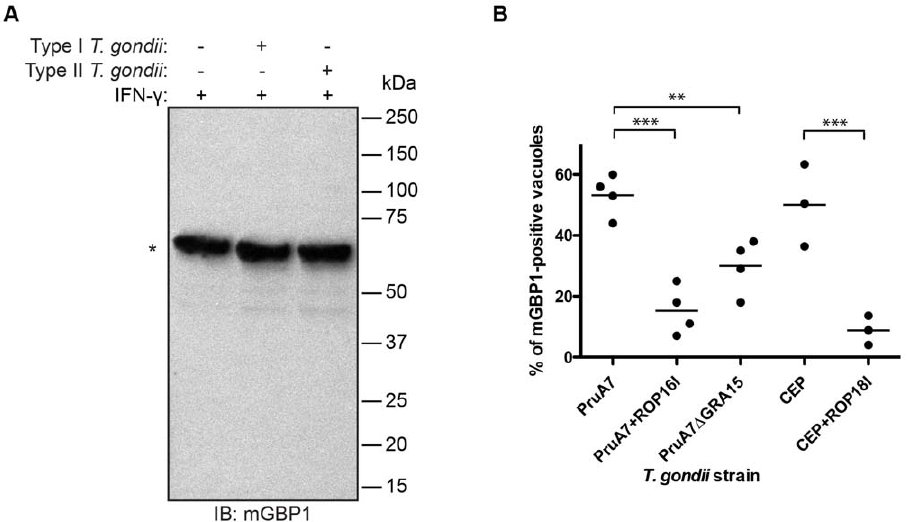
Figure 2. T.gondii cannot degrade mGBP1 but parasitic virulence factors interfere with recruitment of mGBP1. (A) Degradation of mGBP1 after invasion of T. gondii is not detectable by IB. RAW264.7 cells were induced with 200 U/ml IFN- c overnight and infected with mCherry- expressing T. gondii (Pru or RH). Infected cells were separated from uninfected cells by FACS 2 h post-infection. For each lysate, 50 m g of protein, which was equivalent to 300,000 cells, were loaded per lane. The mGBP1 protein was detected by rabbit polyclonal anti-mGBP1 antiserum (*). (B) Type II strains with deleted GRA15, type II strains transgenic for the type I version of ROP16, and type III strains transgenic for the type I version of ROP18 show less mGBP1-positive vacuoles compared to the parental strain. MEFs that overexpress eGFP-mGBP1 were induced with 200 U/ml IFN- c and infected with PruA7, a Pru type II T. gondii strain, PruA7 either lacking GRA15 or transgenic for the type I version of ROP16, CEP, a type II strain, or CEP transgenic for the type I version of ROP18. For each strain, at least 100 vacuoles of invaded T. gondii were checked for recruitment of mGBP1. Data represent four independent experiments. Decrease of mGBP1 recruitment is significant with ** p , 0.01 and *** p , 0.001.